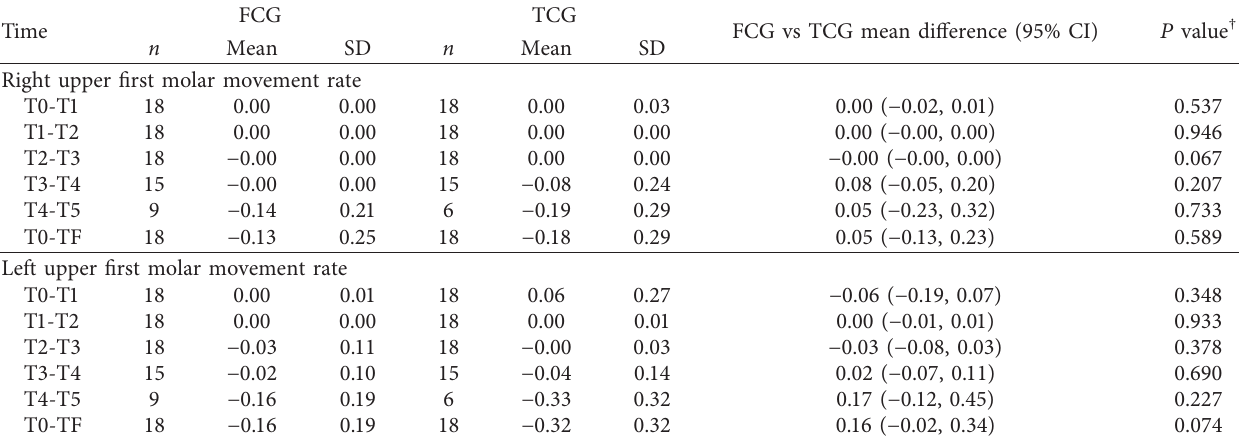
values. Table 3: Descriptive statistics of the upper first molar movement rate (mm/month) as well as the P values of significance tests. Time